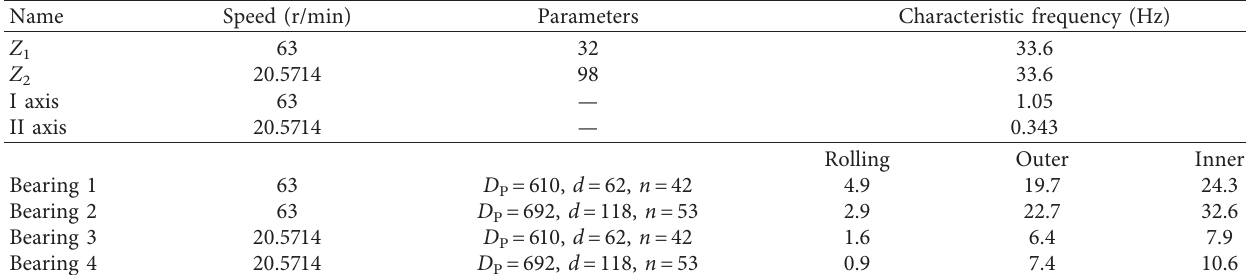
Table 1: Parameters of the